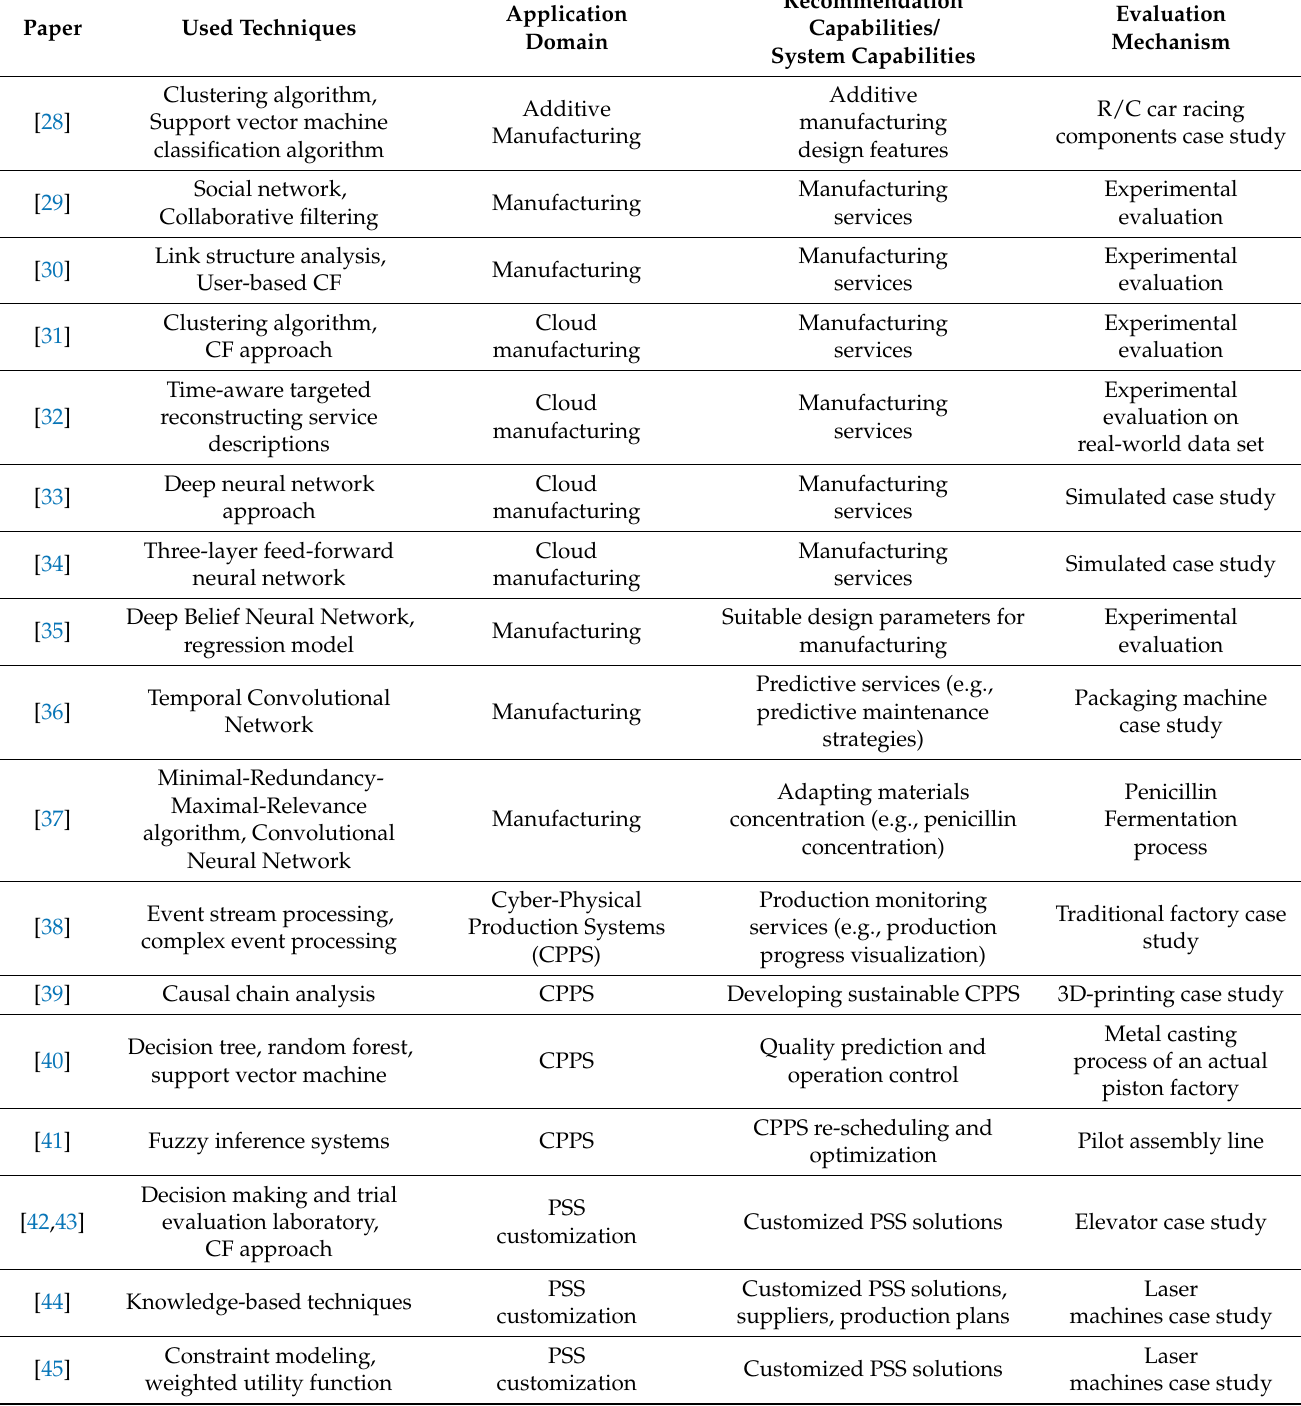
Table 1. Related work recommendation approaches in